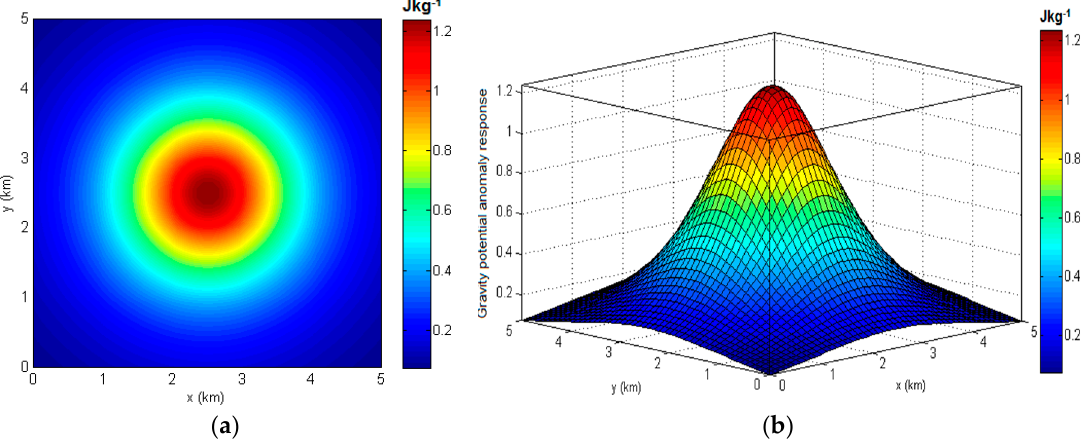
Figure 5. The theoretical response of potential anomaly with size 1 km 3 at 1 km depth with 0.43 g/cm 3 of the density contrast ( a ) a plan view; ( b ) 3D view.